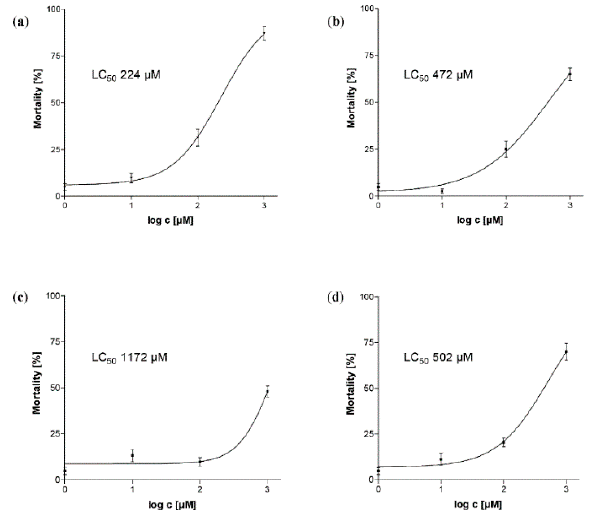
Figure 7. Dose-response curves of tetrameric PACs ( a ) pavetannin C1 ( 3 ), ( b ) epicatechin-(4 β → 8)- epicatechin-(2 β → O → 7, 4 β → 8)-epicatechin-(4 β → 8)-epicatechin ( 4 ), ( c ) parameritannin A-1 ( 5 ) and ( d ) cinnamtannin A2. Corresponding LC 50 values as obtained by nonlinear regression are given within the respective curve.